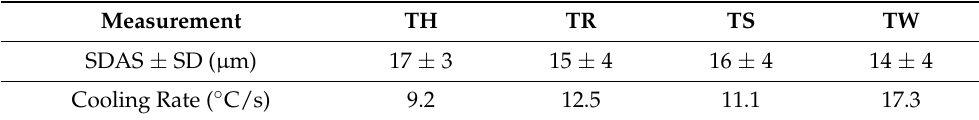
Table 4. Summary of the grain size, SDAS and cooling rate for the T5 heat-treated component.